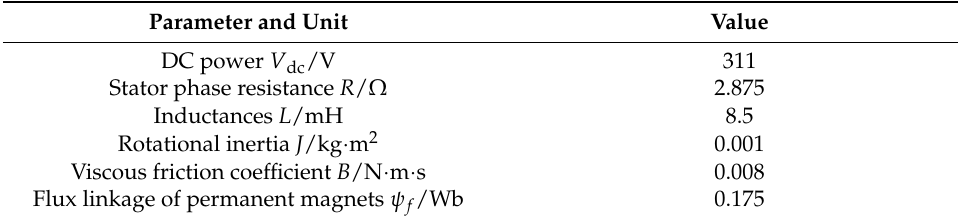
Figure 2. Unmatched disturbances. Table 1. Parameters of the motor.